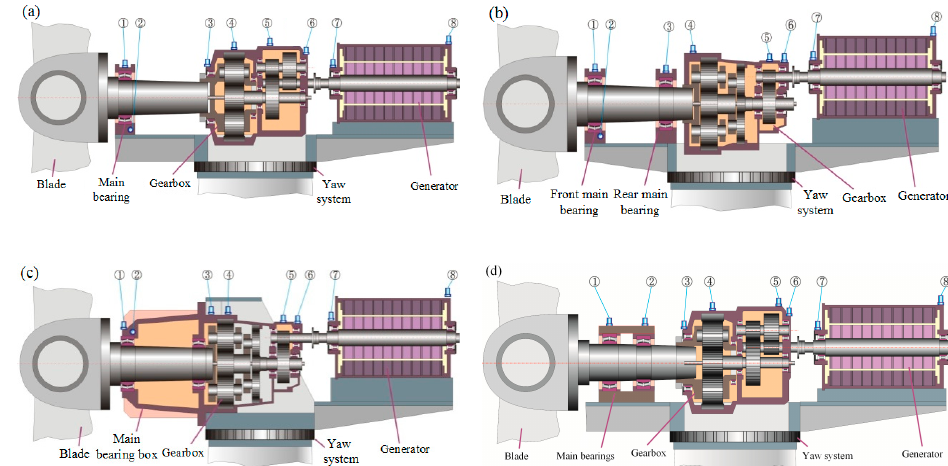
Figure 1. Drivetrains of doubly fed wind turbines: ( a ) independent front bearing pedestal, and rear bearing in gearbox; ( b ) independent pedestal for both front and rear bearing; ( c ) main bearing box and gearbox are combined together; ( d ) front bearing and rear bearing share one pedestal.